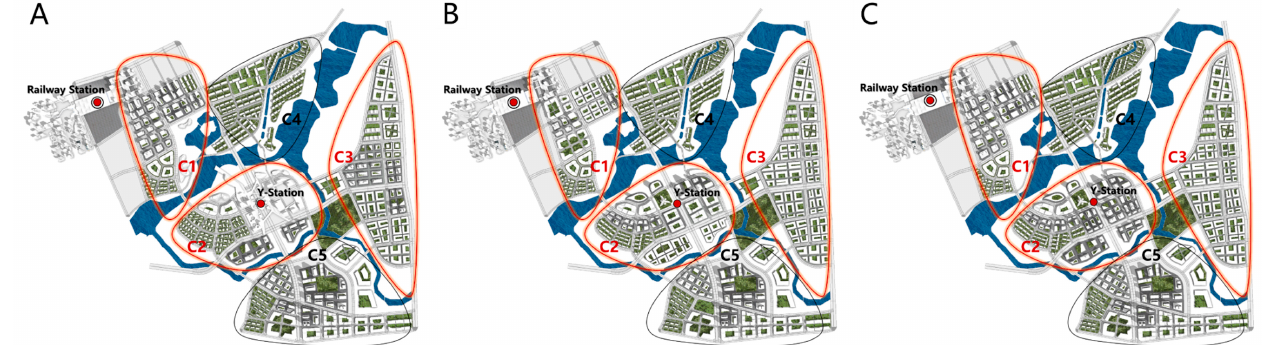
Figure 15. Three alternative proposals in the air–rail line project (Proposal ( A ) employing a high-density development and centralized landscape system in a high traffic need situation in both the railway station and Y-Station, Proposal ( B ) employing a low-density development and decentralized landscape system in a low traffic need situation in both the railway station and Y-Station, Proposal ( C ) employing a medium-density development and decentralized landscape system when there is a high traffic need at the railway station and a medium traffic need in Y-Station).